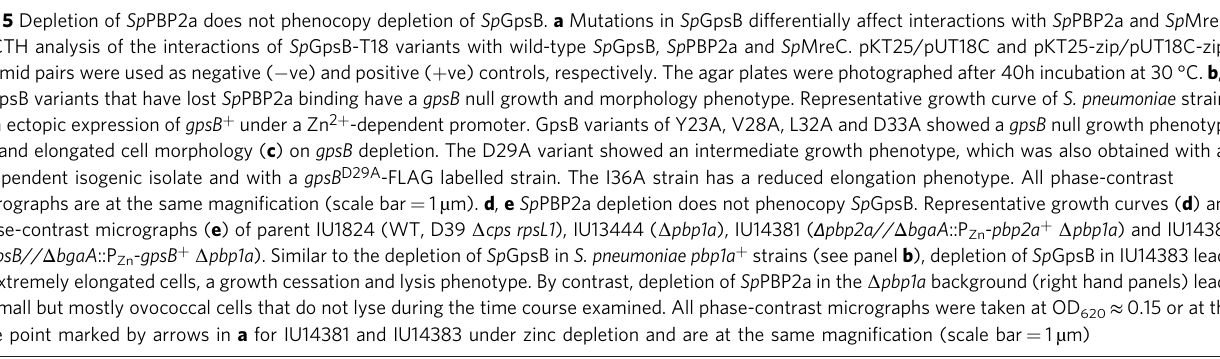
Fig. 5 Depletion of Sp PBP2a does not phenocopy depletion of Sp GpsB. a Mutations in Sp GpsB differentially affect interactions with Sp PBP2a and Sp MreC. BACTH analysis of the interactions of Sp GpsB-T18 variants with wild-type Sp GpsB, Sp PBP2a and Sp MreC. pKT25/pUT18C and pKT25-zip/pUT18C-zip plasmid pairs were used as negative ( − ve) and positive ( + ve) controls, respectively. The agar plates were photographed after 40h incubation at 30 °C. b ,